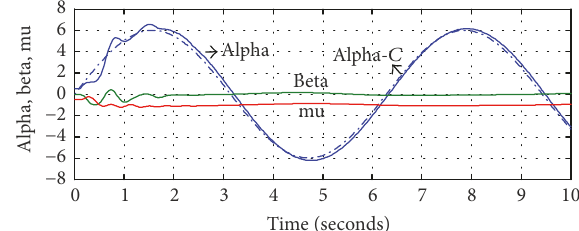
Figure 9: Compensated tracking results of AOA sinus.